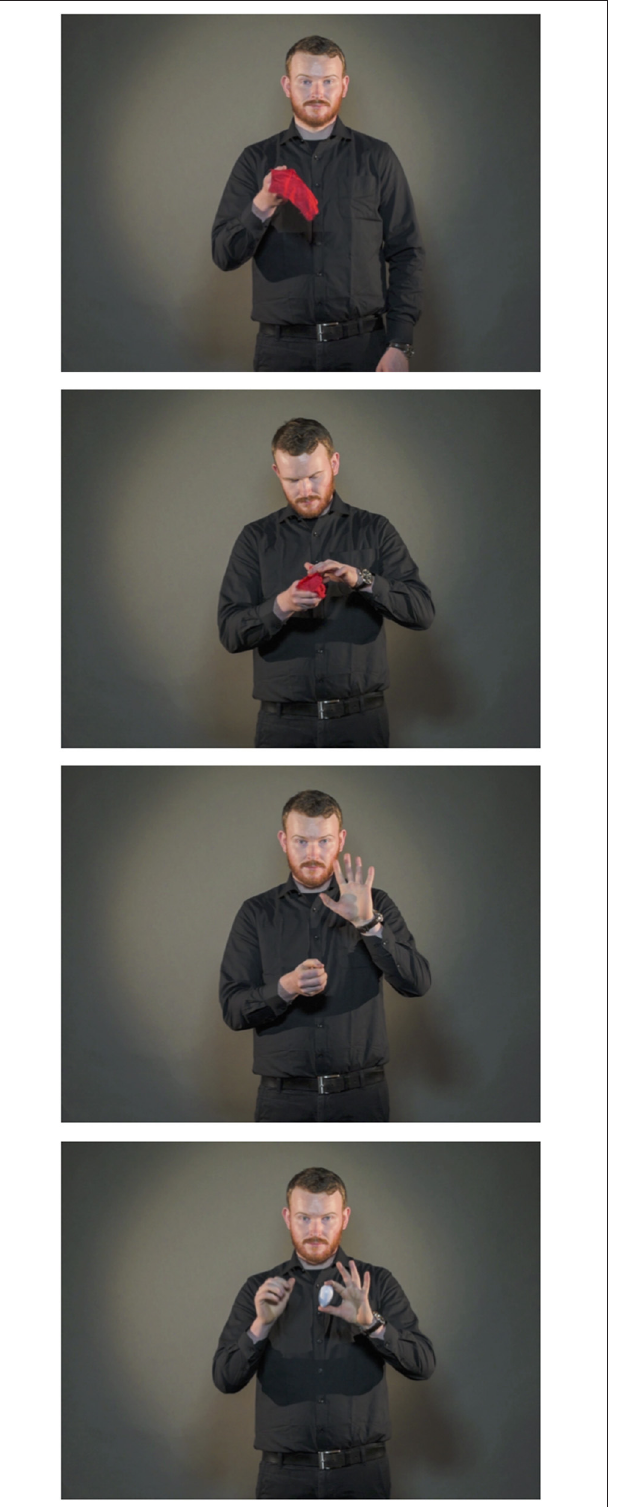
FIGURE 1 | Picture sequence illustrating the magic trick Silk to egg (Example 1). The full clip is available at https://www.youtube.com/watch?v= _jE25LbLaoQ.